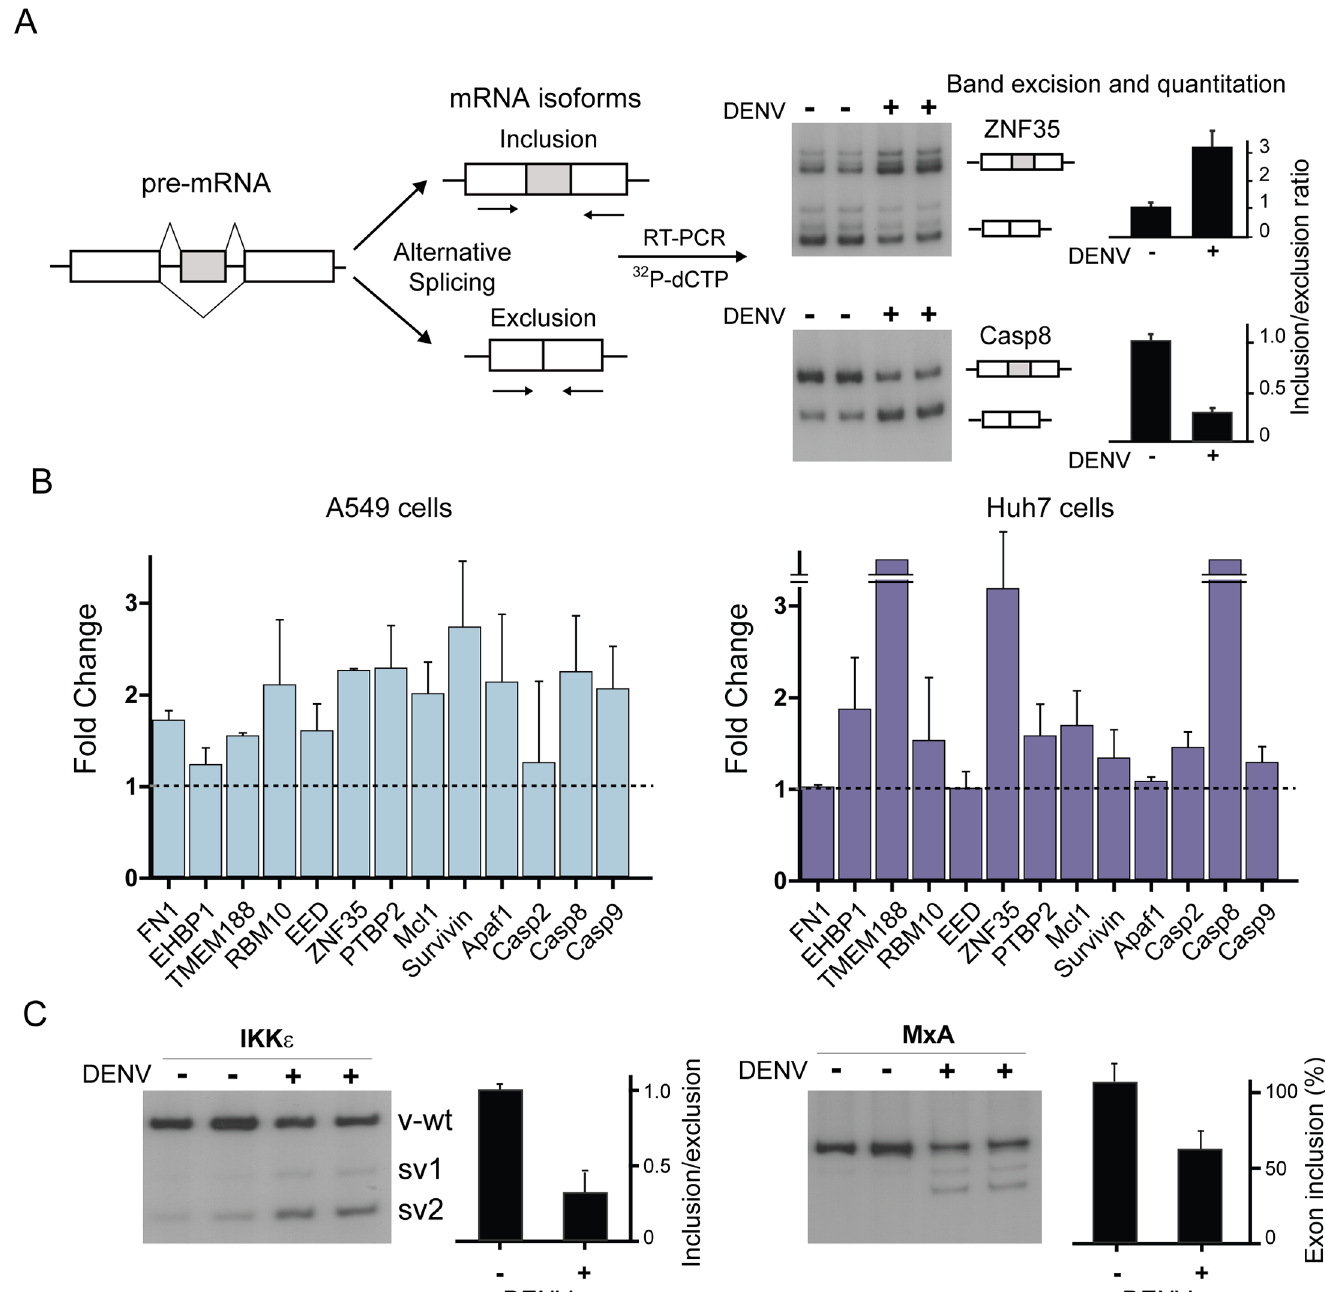
Fig 3. DENV infection modifies the splicing landscape of host cells. (A) Strategy to detect and quantify alternative splicing isoforms in mock infected or DENV infected cells is depicted on the left. Representative autoradiographs and quantification of the inclusion/exclusion ratio for two alternative exon cassette events are shown (duplicates, mean ± SD). (B) Fold-change of inclusion/exclusion ratios for DENV or mock infected cells. A battery of endogenous alternative exon-cassette events (duplicates, mean ± SD) in A549 and Huh7 cells is shown. (C) DENV-induced changes in the splicing pattern of IKK ε and MxA mRNAs. Quantification of alternative splicing events is shown for each case.